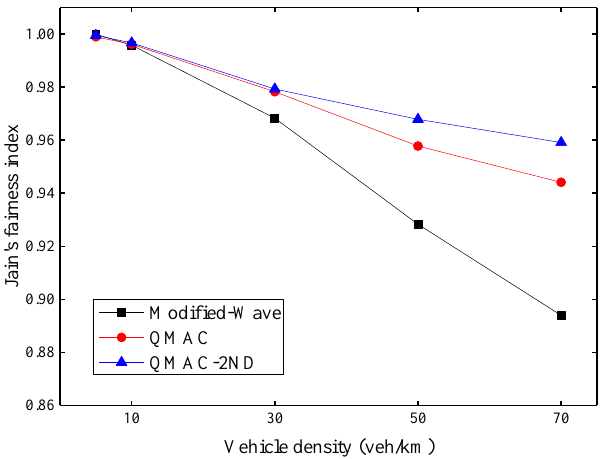
Figure 11. Jain’s fairness index under different vehicle densities.